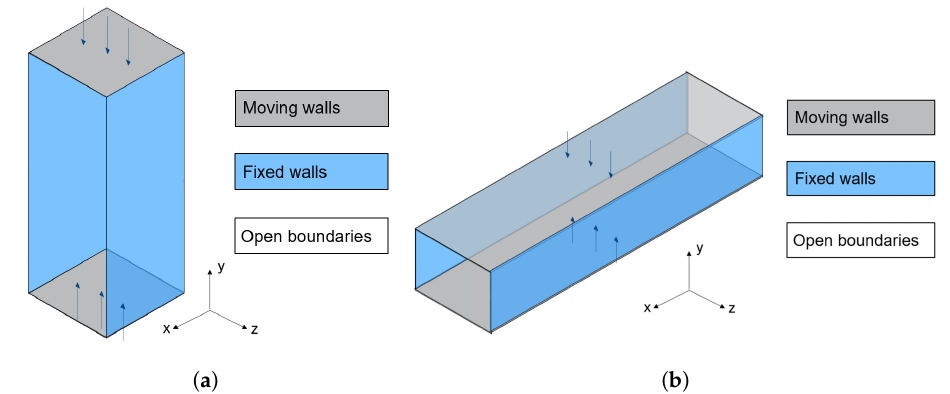
Figure 4. Visualization of the boundary walls of the RVE for elongational flow. ( a ) Before the start of simulation. ( b ) After the end of